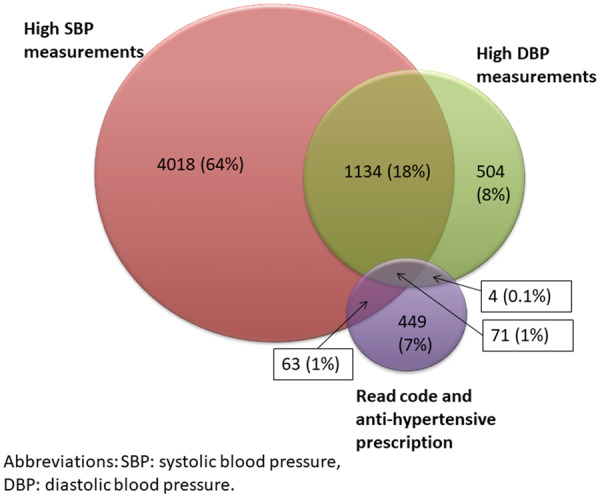
Venn diagram showing how hypertension was identified